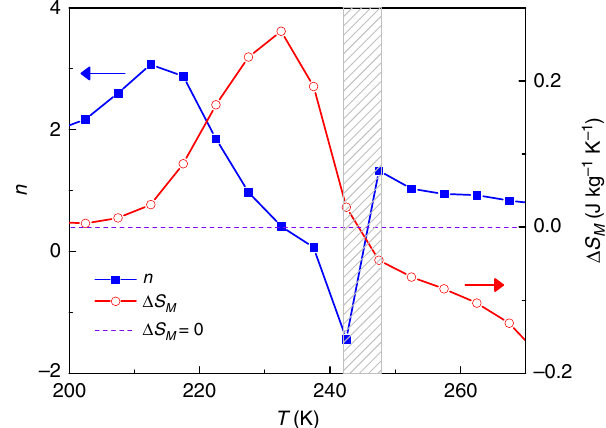
Fig. 10 Inverse magnetocaloric response of GdBaCo 2 O 6 − δ for 1.5 T. The overshoot of n is observed near its fi rst order antiferromagnetic – ferromagnetic transition. Characteristic spikes shown in the shaded gray region indicate the switching from inverse to conventional